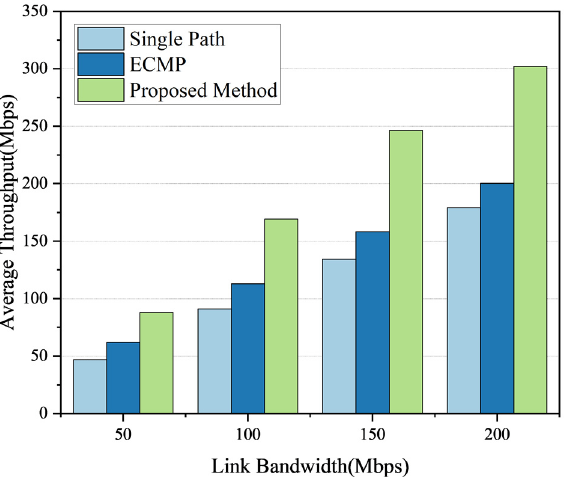
Figure 5. The average throughput under different link bandwidths.